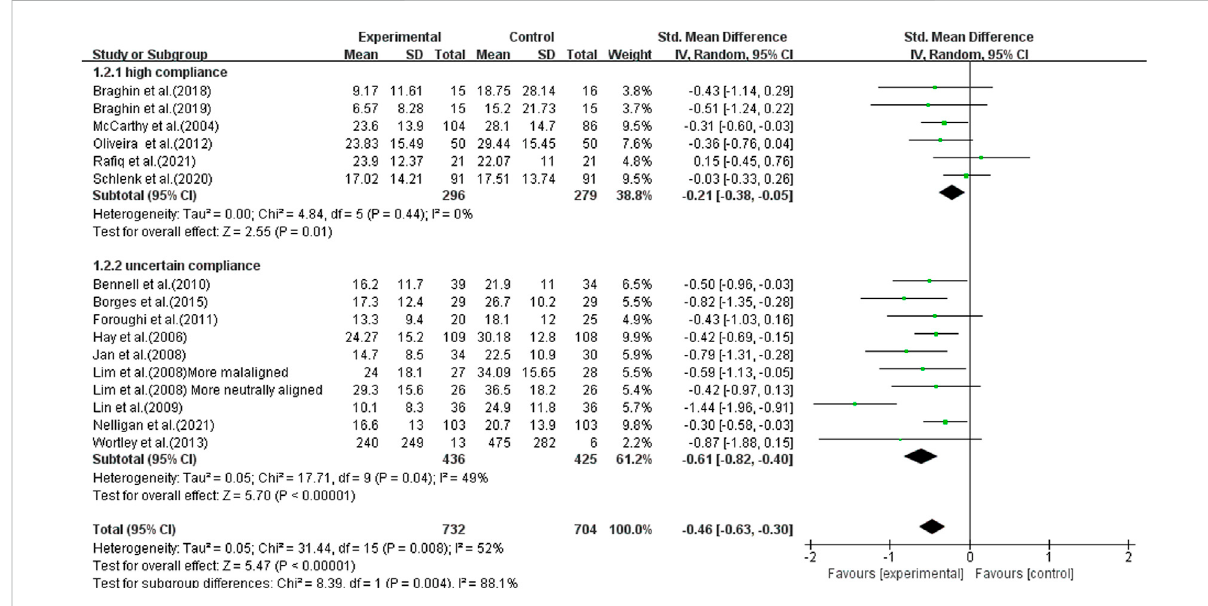
FIGURE 6 Forest plot of comparison: high versus uncertain, outcome: 1.2 Physical function (WOMAC). A random-effects model was used because of signi fi cant heterogeneity (l 2 = 52%). Effect of land-based exercise compared to control when physical function outcomes were assessed using the WOMAC function subscale. Data are presented as standardized mean differences, with differences < 0 favoring land-based exercise. Subgroup analysis showed similar effects for physical function in the high-compliance group [SMD − 0.21 (95% CI − 0.38, − 0.05), I 2 = 0%] ( p = 0.010) and those with the uncertain-compliance group [SMD − 0.61 (95% CI − 0.82, − 0.40), I 2 = 49%] ( p < 0.001).